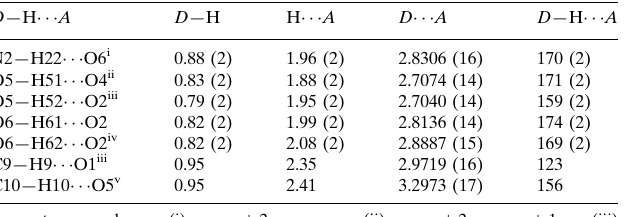
Hydrogen-bond geometry (A˚ , (cid:3)